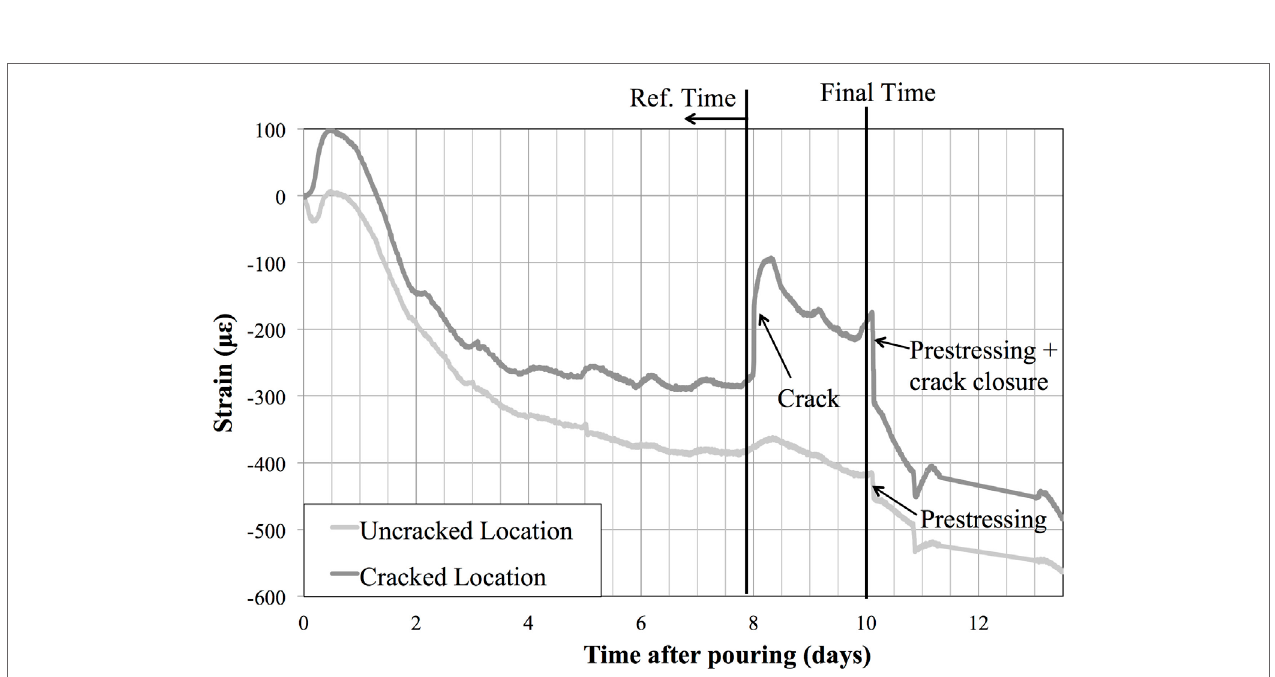
FIGURe 4 | example of a time history of strain measurements for healthy (uncracked) and a cracked locations showing crack occurrence, prestressing, and reference and final times .